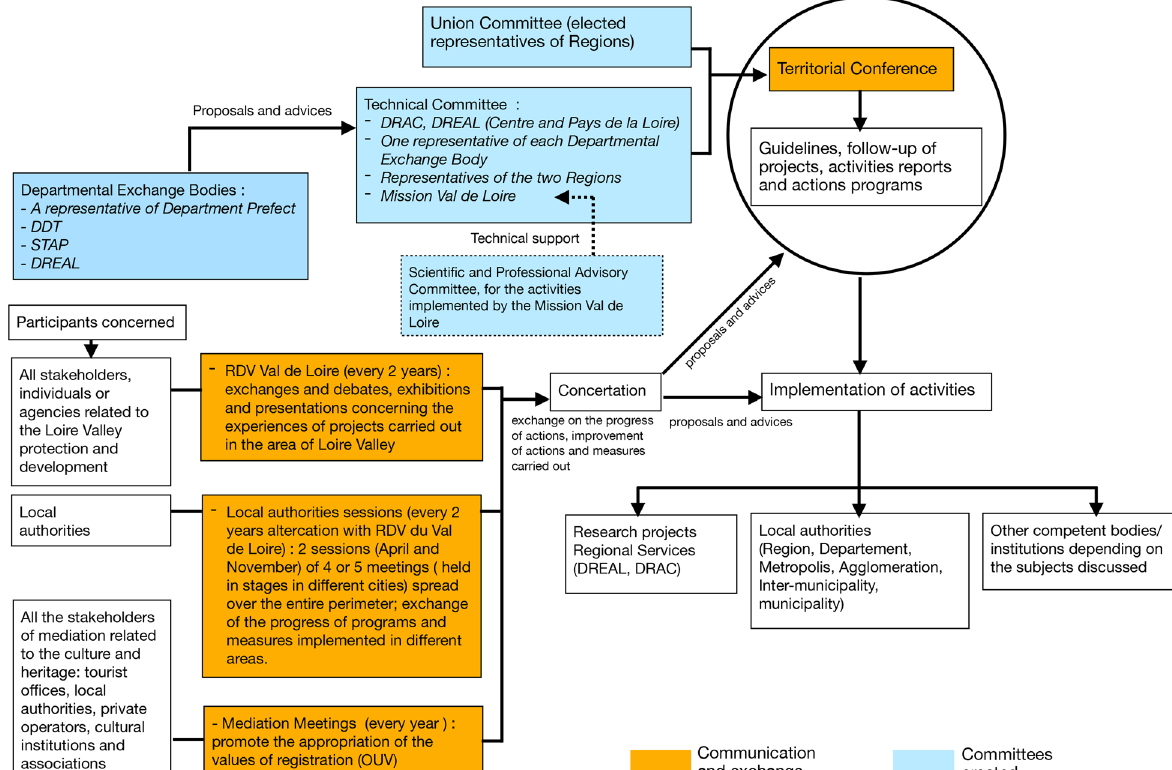
Fig. 6 Schema of concertation and communication (Source: Peng